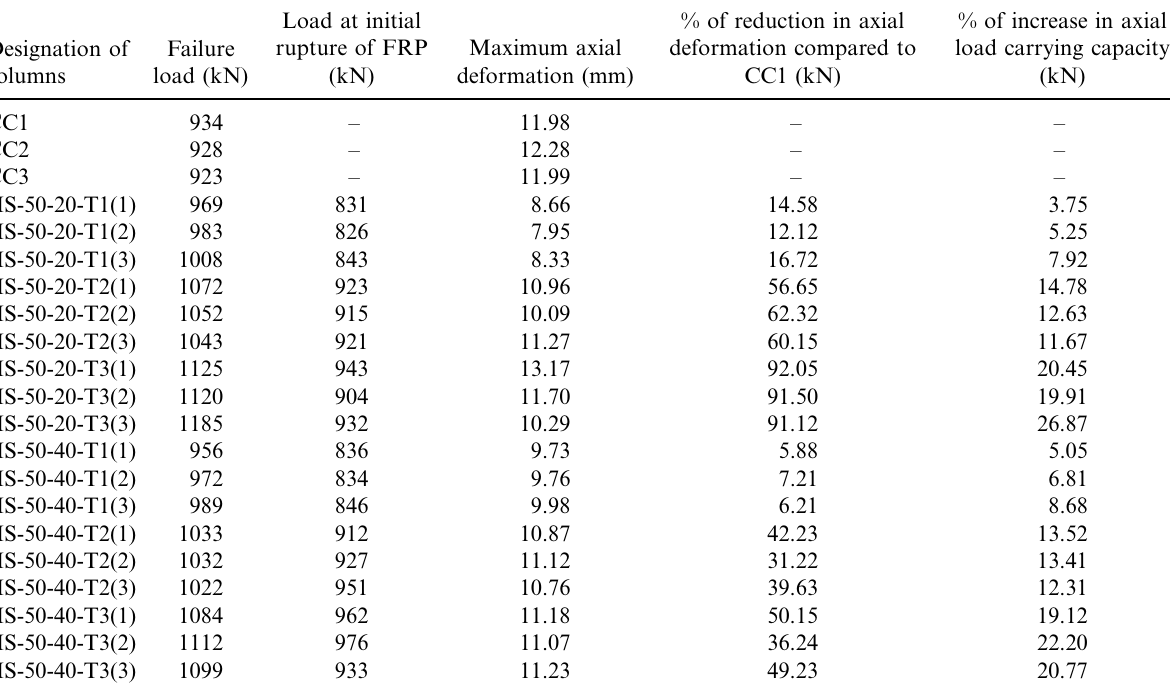
Table 4. Failure load and Load carrying capacity of all